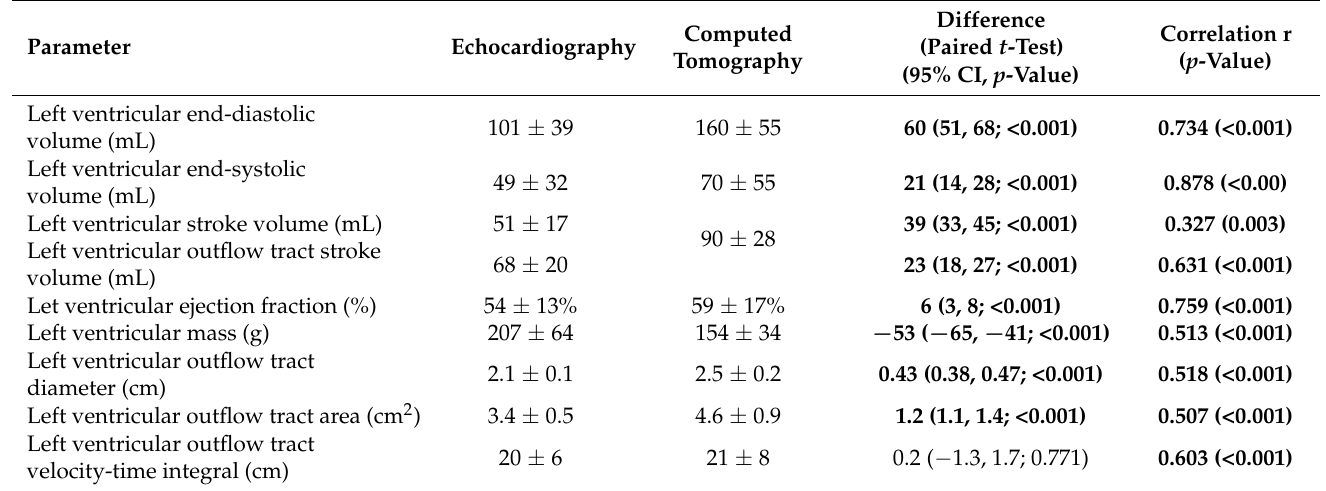
Table 3. Comparisons and correlations between echocardiography and computed tomography measures of left ventricular and outflow tract parameters.